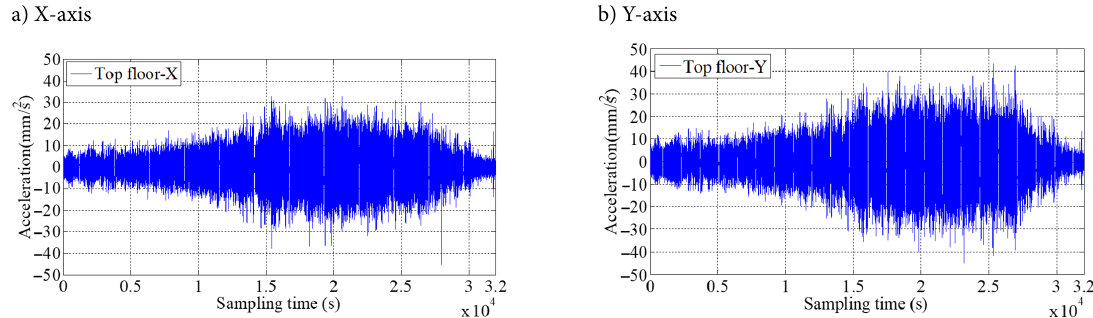
Figure 6. Time history of acceleration on the top floor under the influences of Typhoon